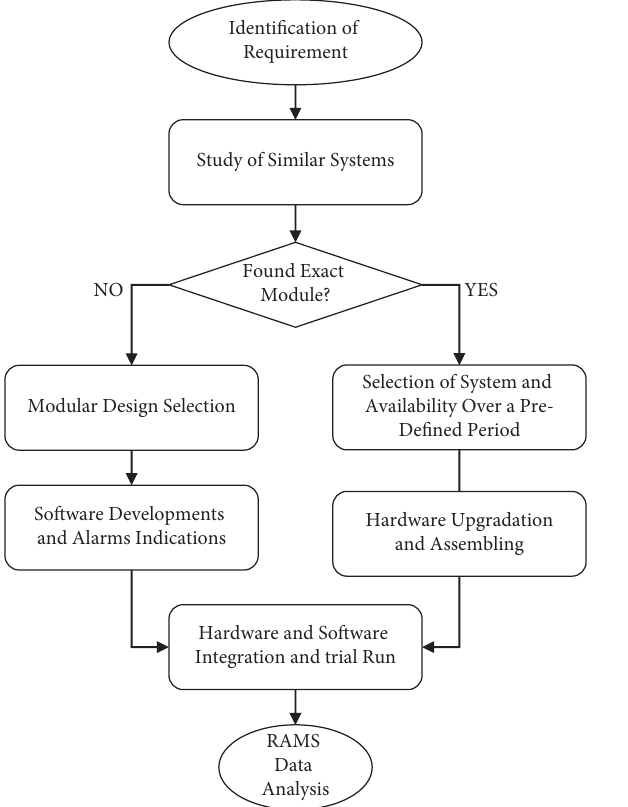
Figure 1: Schematic diagram of research methodology.